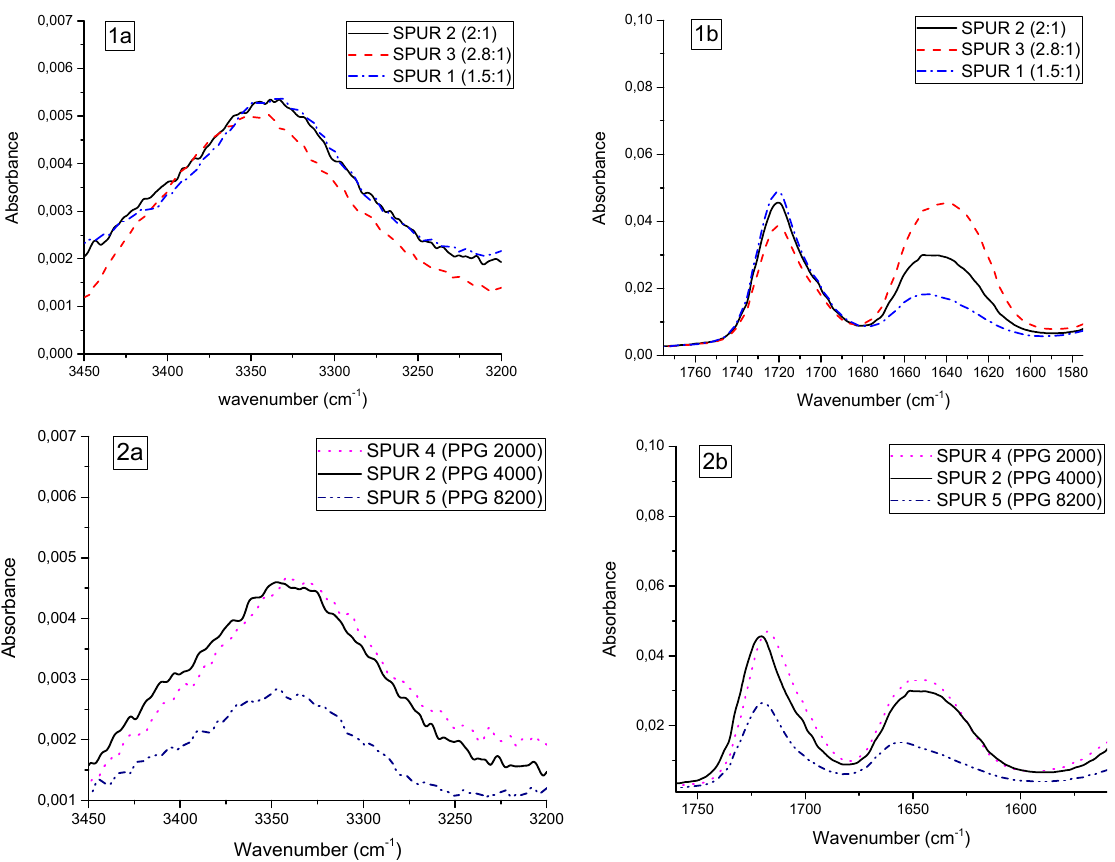
Figure 8. The ATR-FTIR spectral comparison of relevant samples with different variables in N–H stretching region (3450–3200 cm − 1 ) (left) and C=O stretching region (1760–1600 cm − 1 ) (right). ( 1a , b ): Impact of NCO/OH ratio; ( 2a , b ): Impact of PPG chain length.